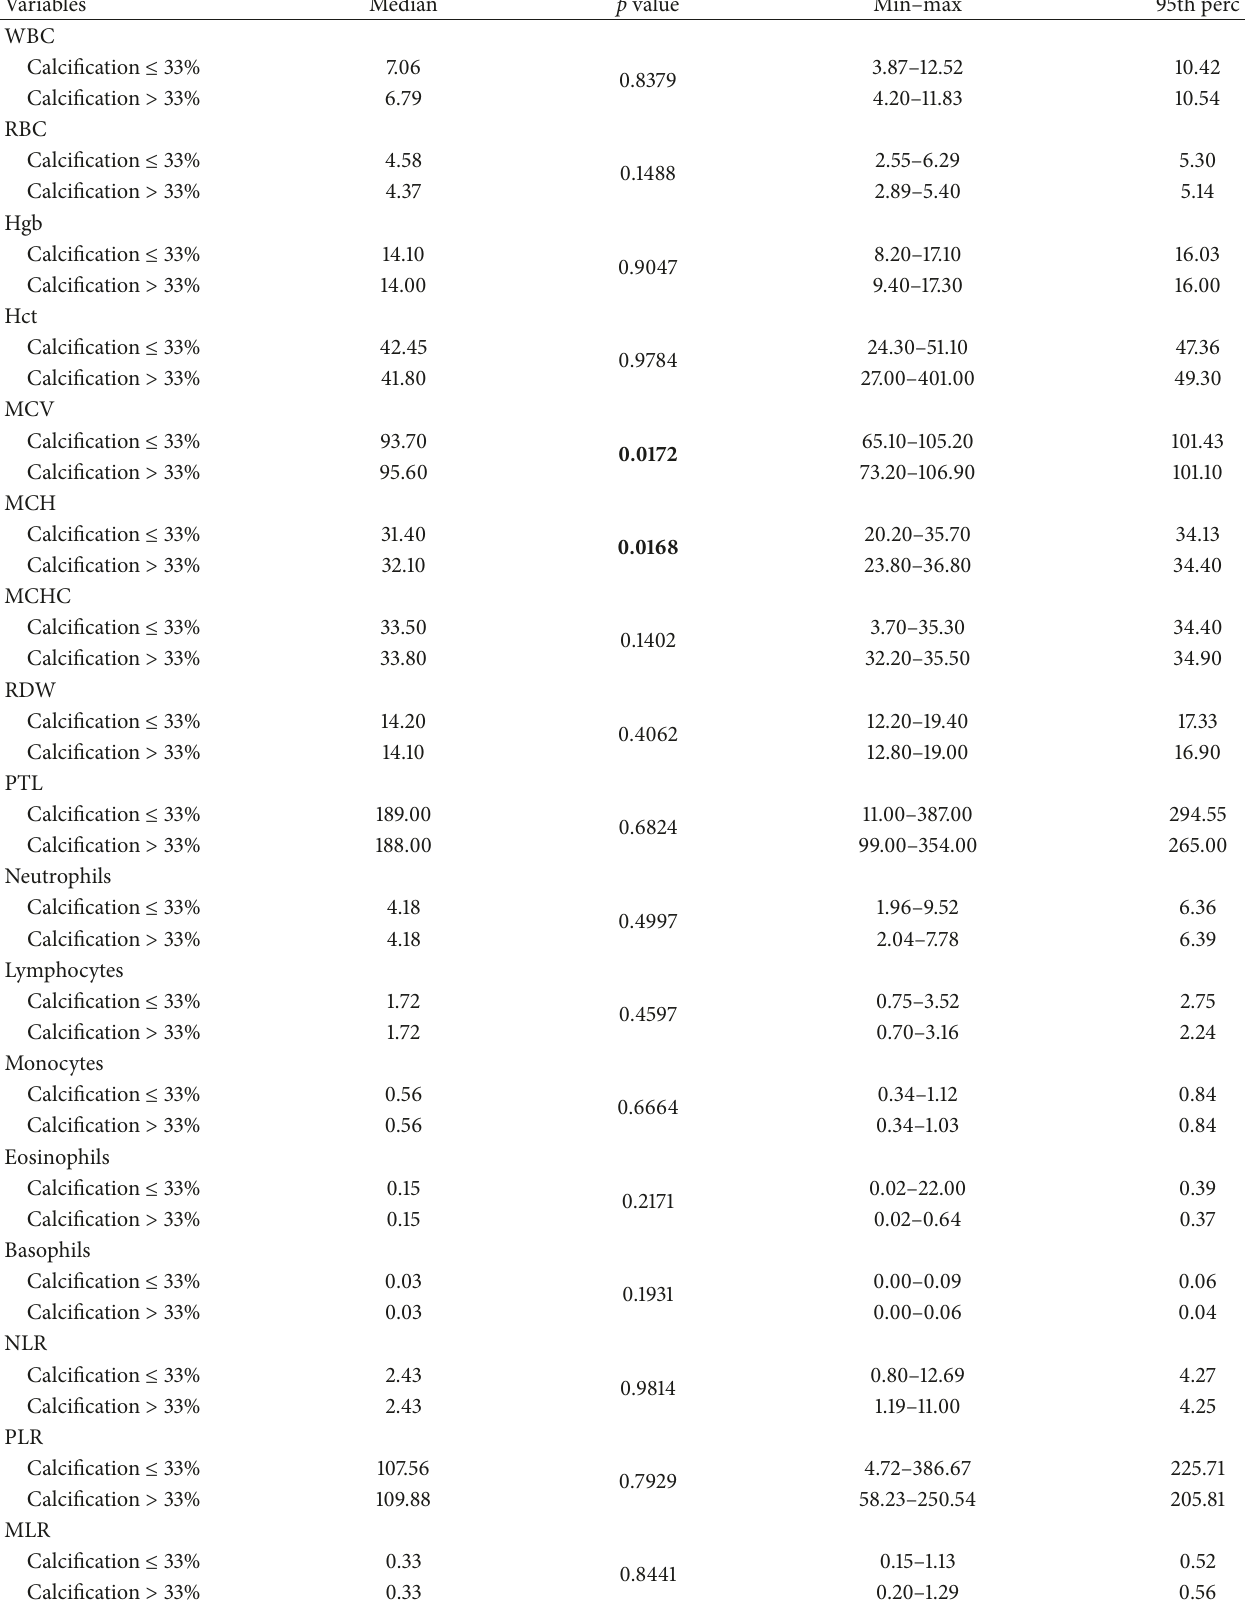
Table 4: Wilcoxon signed-rank test for variables related to blood count. In bold, p value <